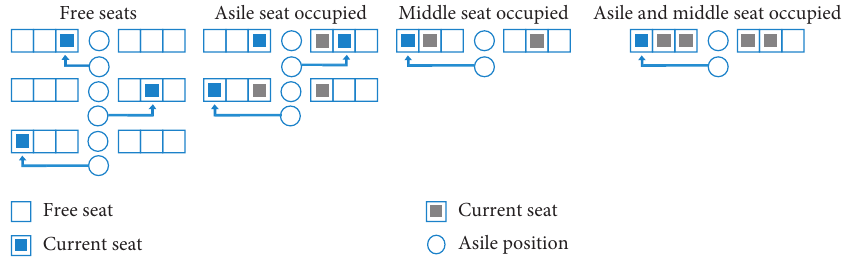
Figure 1: The available seats in different conditions.